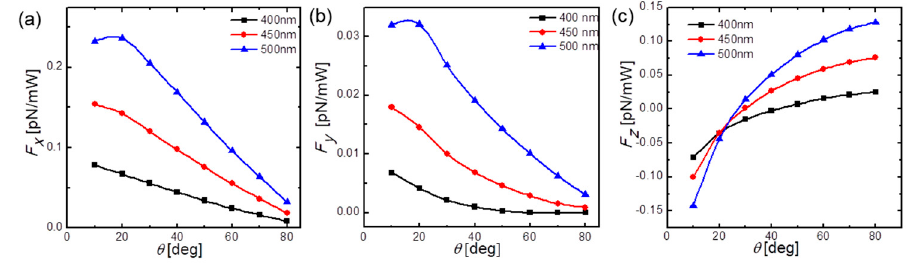
Figure 4. Calculated total optical force ( a ) F x , ( b ) F y , ( c ) F z upon varying inclination angles θ for SD optical fiber diameters of 400, 450, and 500 nm.